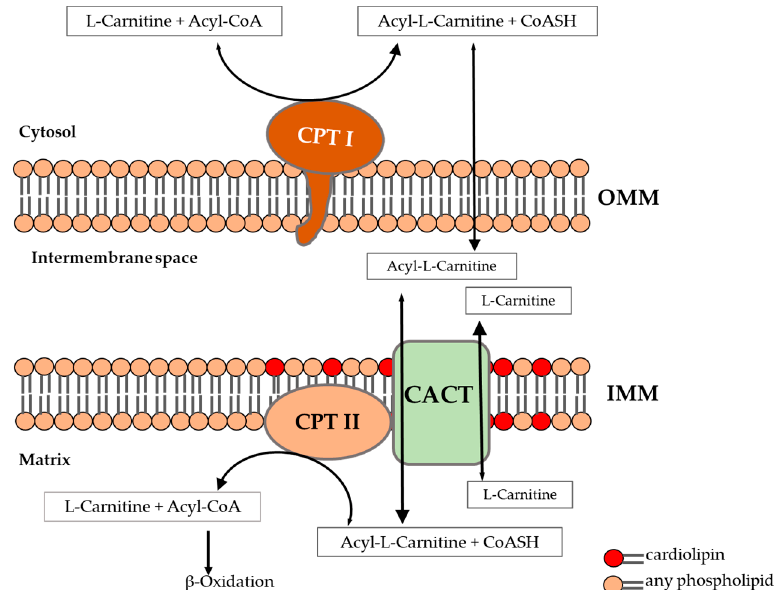
Figure 1. Transport of fatty acids through mitochondrial membrane via carnitine shuttle modified according to McGarry [3]. CPT, carnitine palmitoyltransferase, CACT, carnitine:acylcarnitine translocase, CoA, Coenzyme A, IMM, inner mitochondrial membrane OMM, outer mitochondrial membrane.